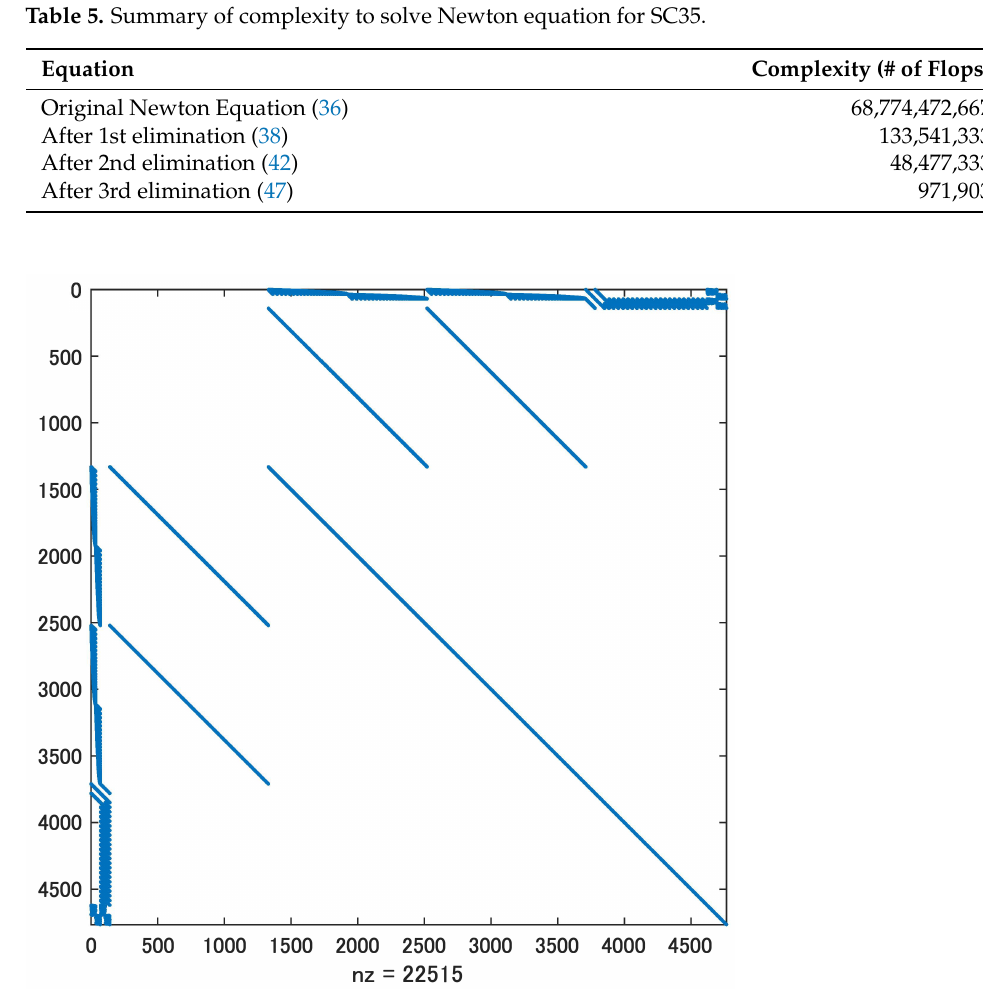
Figure 2. Sparsity pattern of the coefficient matrix of the Newton equation for